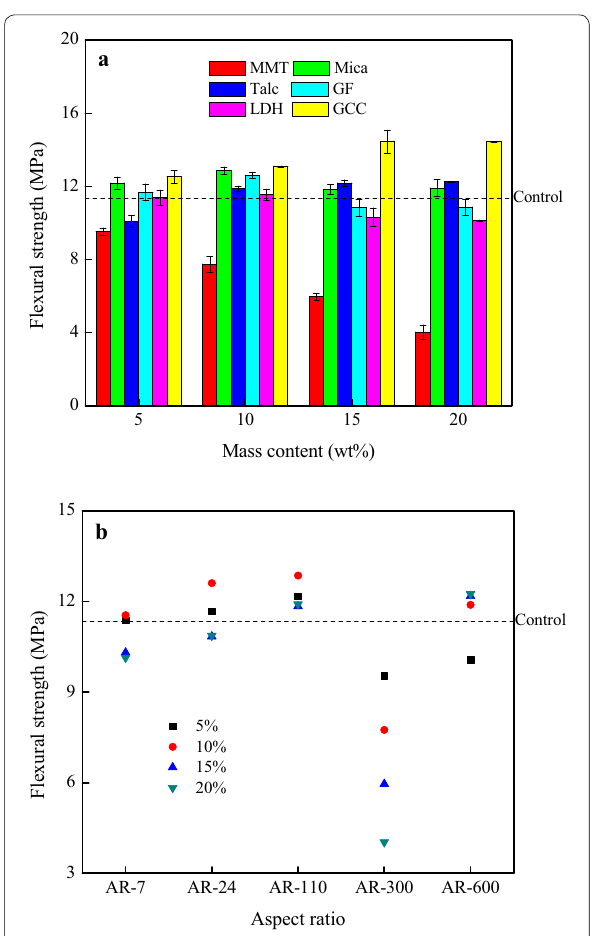
Fig. 1 Flexural strength of the modified EECM with different fillers. a Filler contents; b aspect ratios of